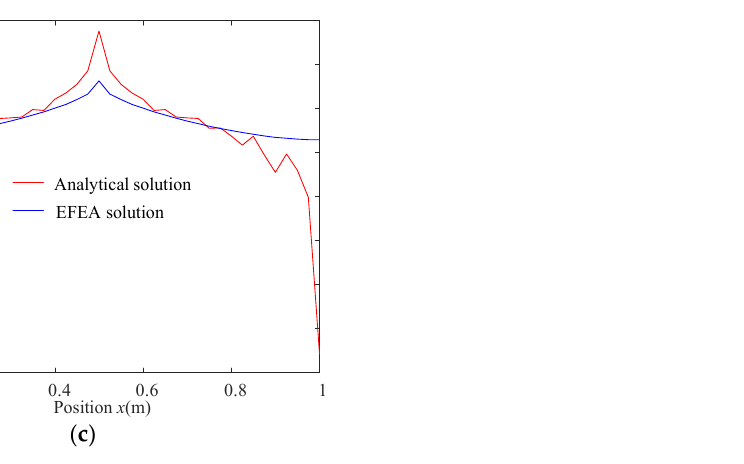
Figure 6. The relationship between wavelength and excitation frequency ( η 2 = 0.8, h 2 = 0.002 m).